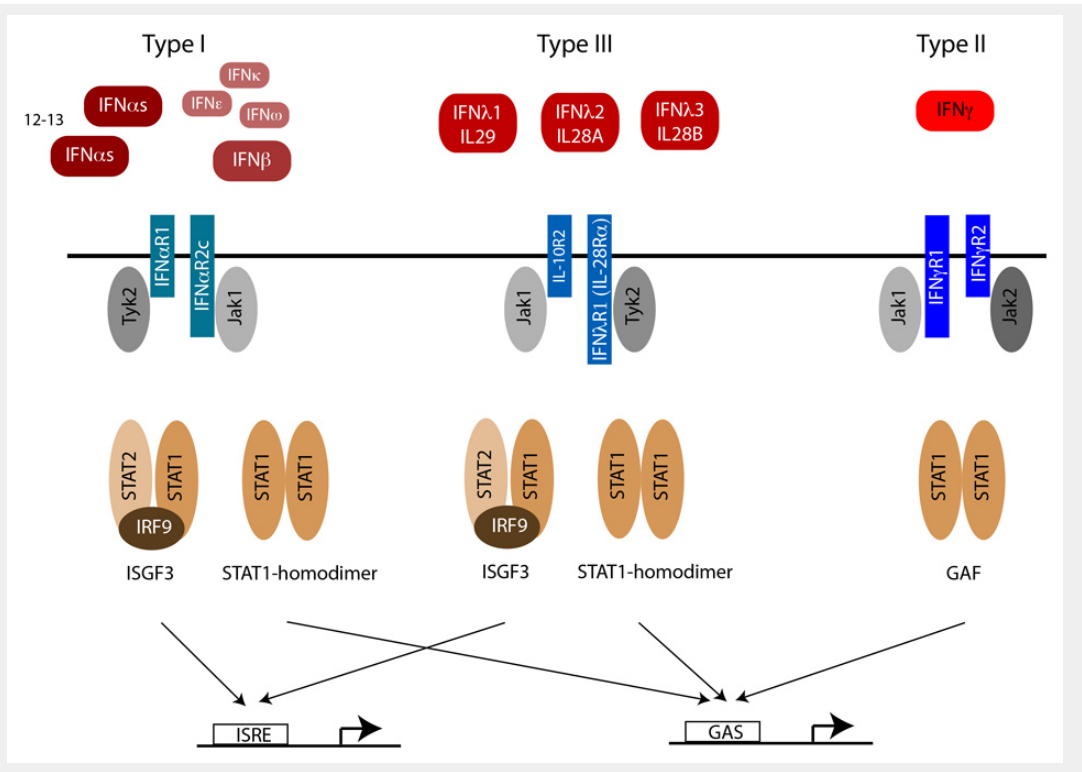
IFN signalling through the Jak-STAT pathway. Type I and III IFNs bind to distinct receptors, but activate the same downstream signalling pathways, and induce a widely overlapping set of genes through the activation of IFN stimulated gene factor 3 (ISGF3) and STAT1 homodimers. IFNγ, the only type II IFN, activates STAT1 homodimers, but not ISGF3, and thereby induces an overlapping but distinct set of ISGs.